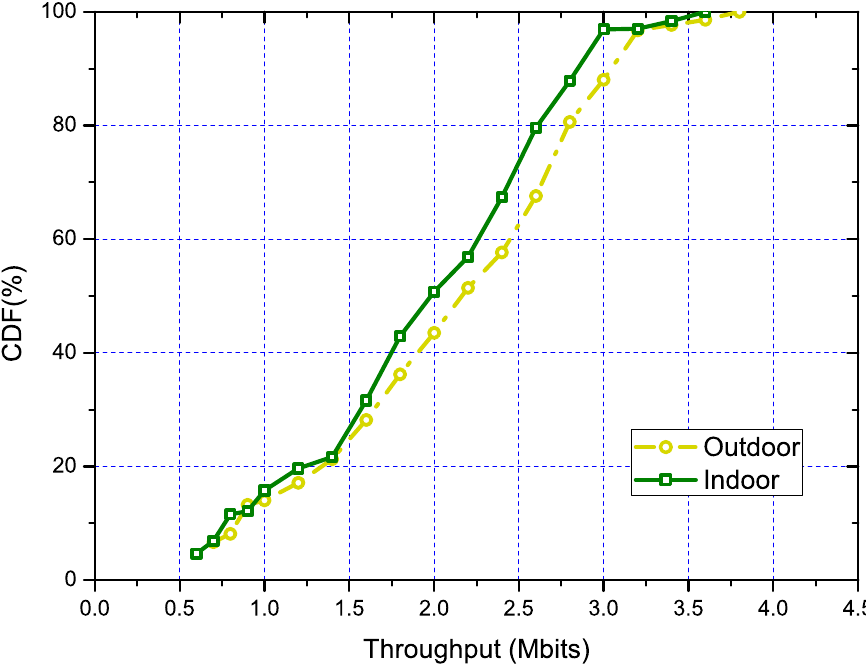
Figure 6. The CDF of throughput under different scenarios of indoor(SWIM) and outdoor(MetroFi) Figure 4. The CDF of throughput under different scenarios for indoors (SWIM) and outdoors